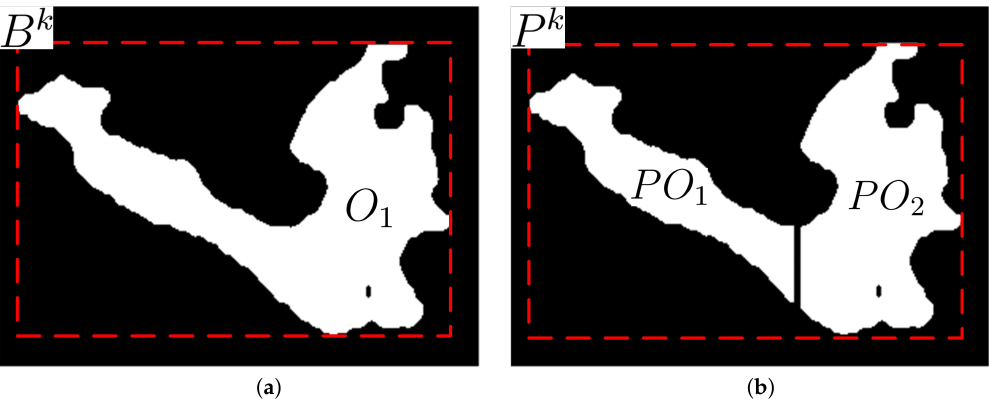
Figure 7. Foreground region partitioned into two smaller regions: ( a ) A foreground region extracted; ( b ) Partitioned regions after the double column scan